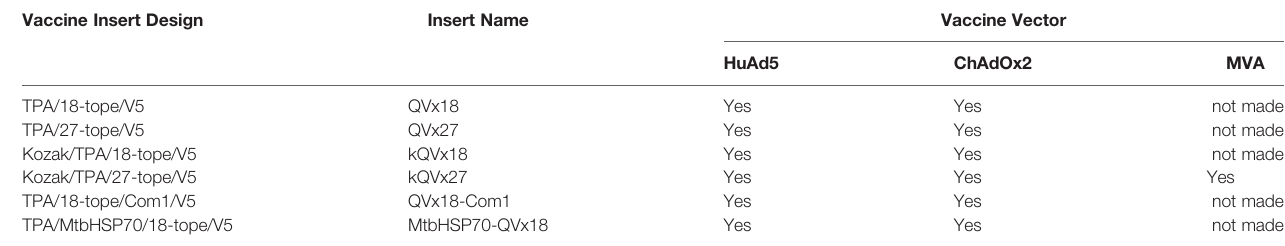
TABLE 1 | Summary of epitope concatemer vaccine